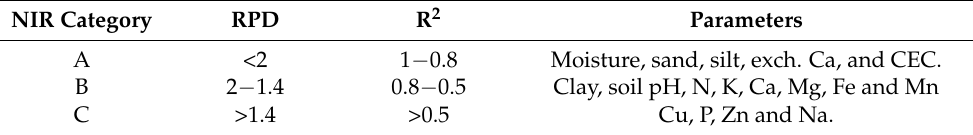
Table 3. NIR spectra predictability categories of soil